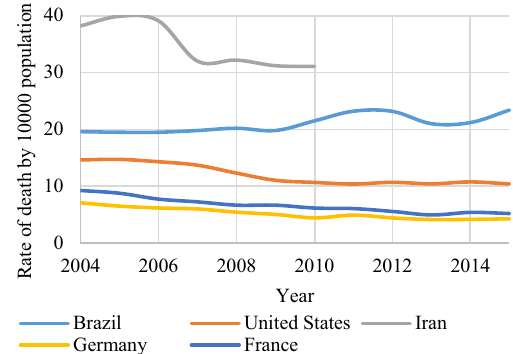
Fig. 1 Traffic accident deaths per 10,000 citizens. Sources : Brazil (DATASUS), United States (NHTSA), Iran [1], Germany (desta- tis.de), and France (www.securite-routiere.gov.fr)